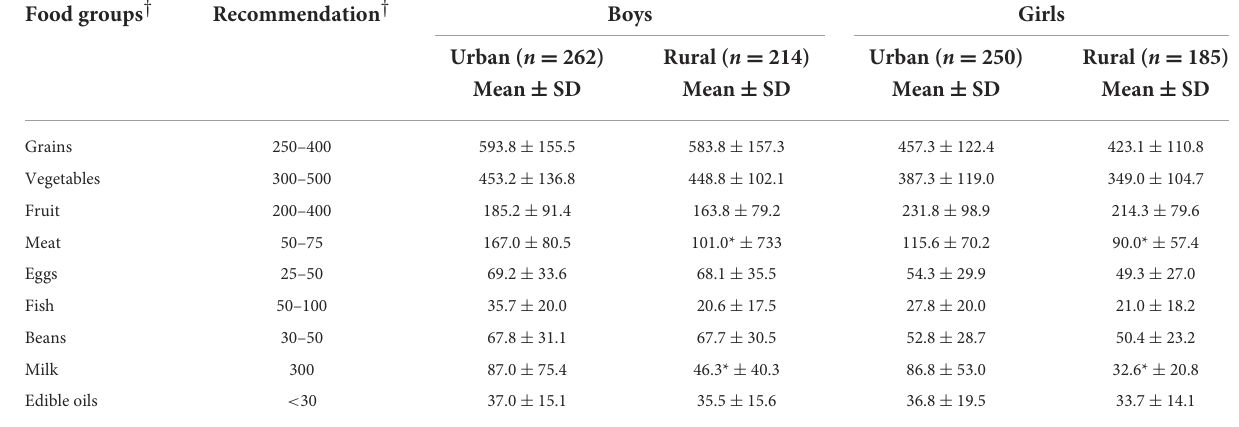
TABLE 3 Daily intake of nine food groups (g).